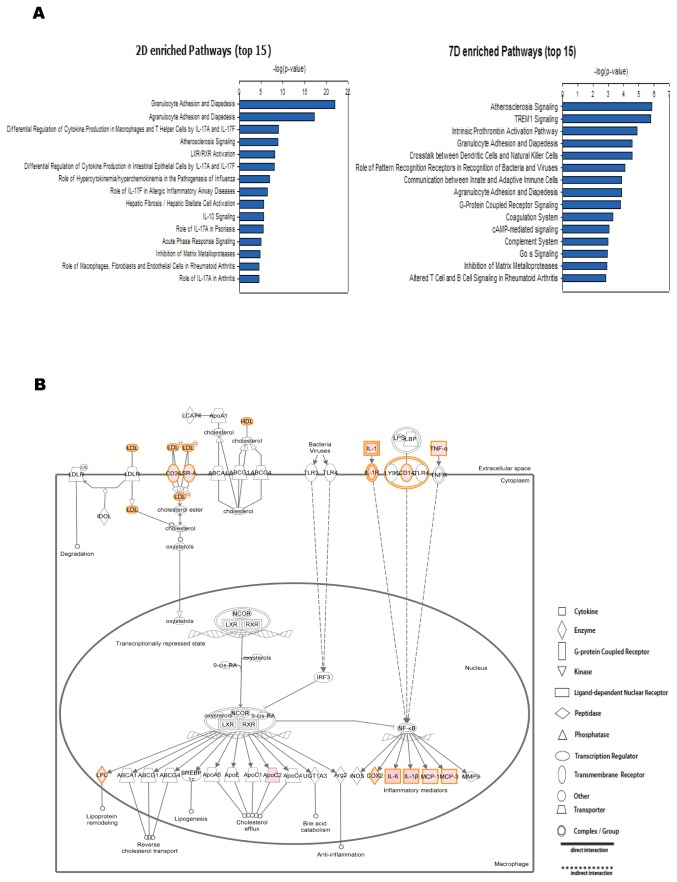
The top canonical pathways enriched in the differentially expressed genes.(A) Top 15 canonical pathways enriched in top 10% up/down-regulated genes of 2D/CTR and 7D/CTR are shown. The –log(P value) of the enrichment of each canonical pathway was plotted. (B) LXR/RXR Activation pathway up-regulated genes are colored pink. The color of a gene reflects its fold change. The higher the fold change the deeper the color.